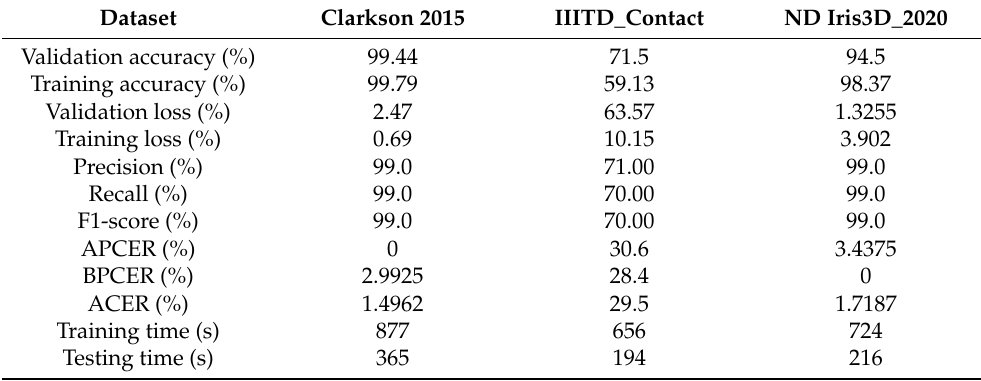
Table 5. Performance evaluation of the InceptionV3 model for iris liveness detection.